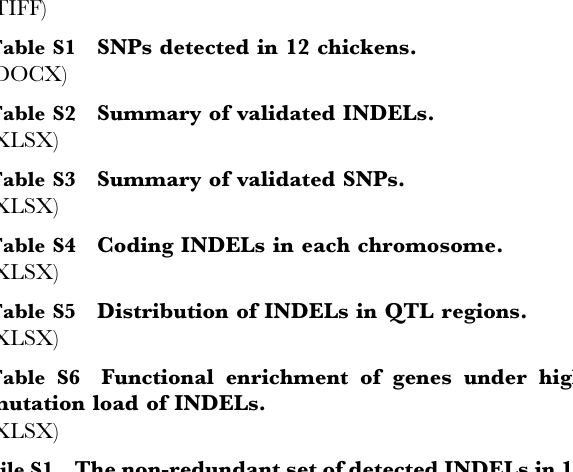
Table S2 Summary of validated INDELs. Table S3 Summary of validated SNPs. Table S4 Coding INDELs in each chromosome. Table S5 Distribution of INDELs in QTL regions. Table S6 Functional enrichment of genes under